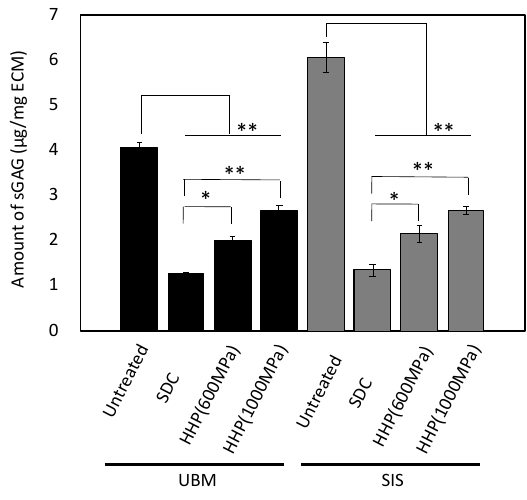
Figure 3. Quantitative analysis of sulfated glycosaminoglycan (sGAG ) in decellularized tissue. * p < 0.05, ** p < 0.01. SDC and HHP represent the method of decellularization of each tissue (urinary bladder matrix (UBM) and small intestine submucosa (SIS)).